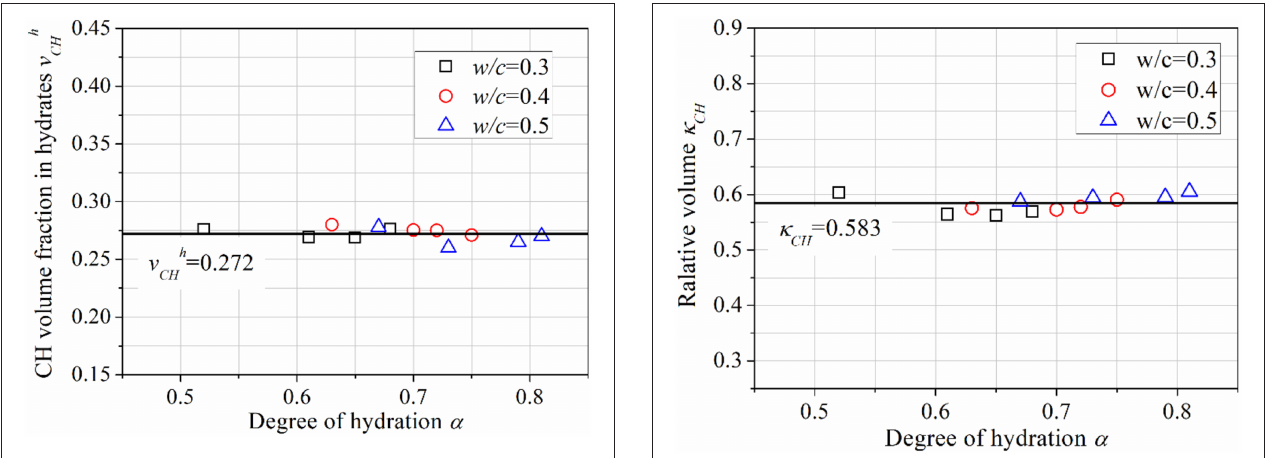
FIGURE 4 | Evolution of v h CH following degree of hydration.